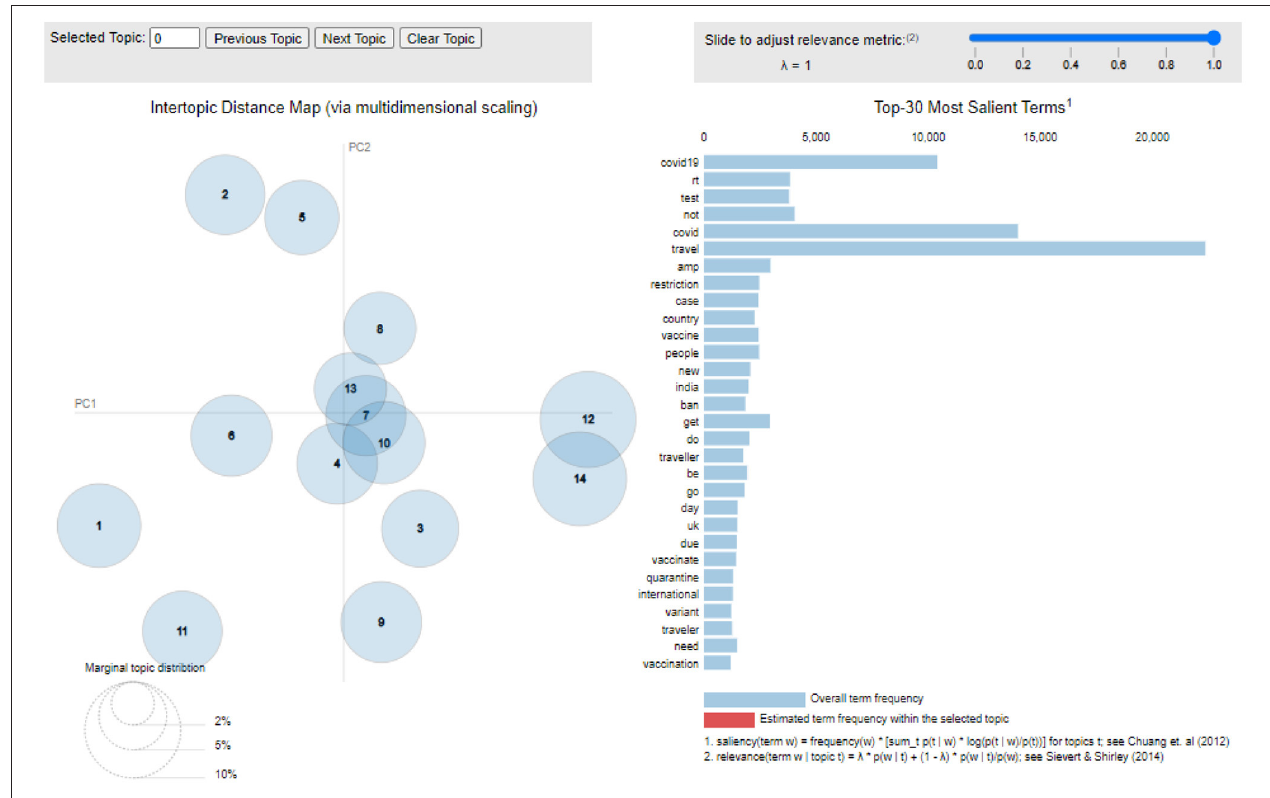
FIGURE 1 | Visual inspection of LDA.